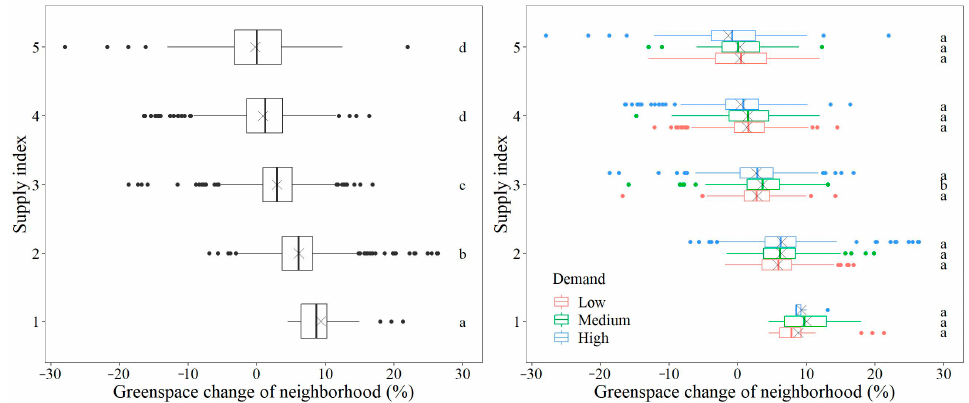
Figure 9. Association between greenspace increase with ( a ) greenspace supply in 2005 and ( b ) different levels of demand (high, medium, and low).